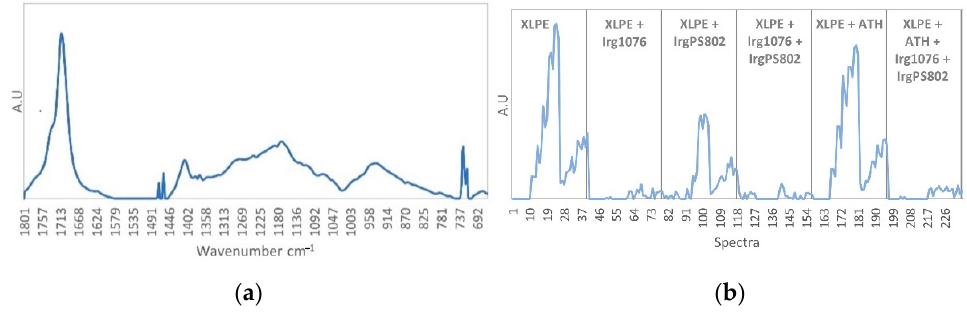
Figure 15. ( a ) Oxidative species pure spectrum. ( b ) Oxidative species concentration profile.